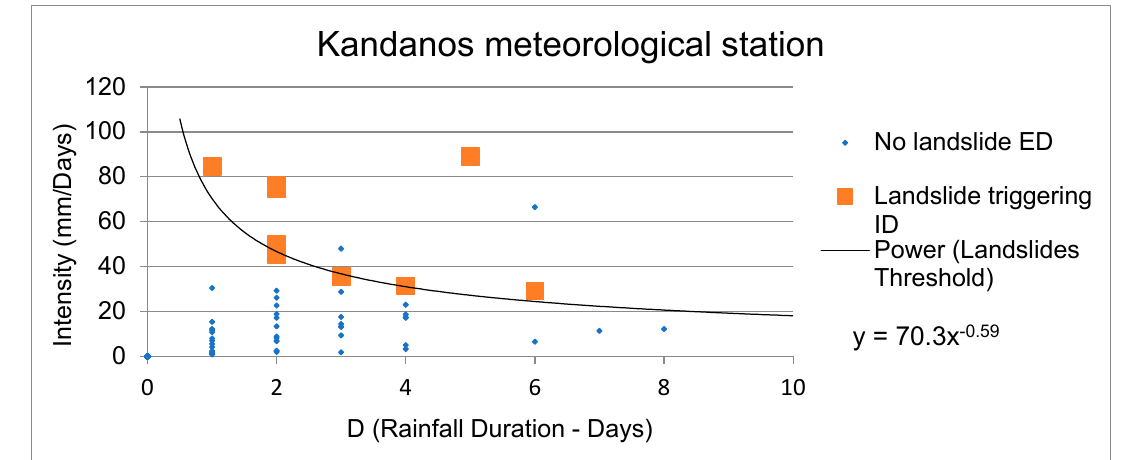
Figure 8. Intensity–duration (ID) diagram for the Kandanos meteorological station according to observations (meteorological data).